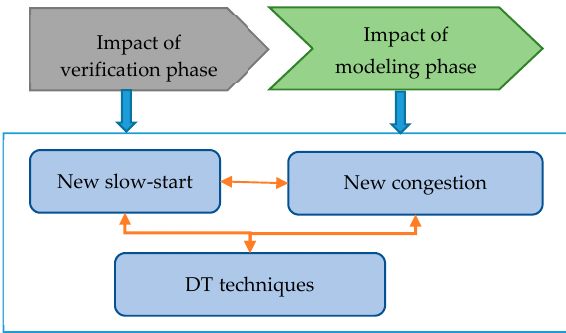
Figure 1. Understanding of the development phase. DT: decision tree.